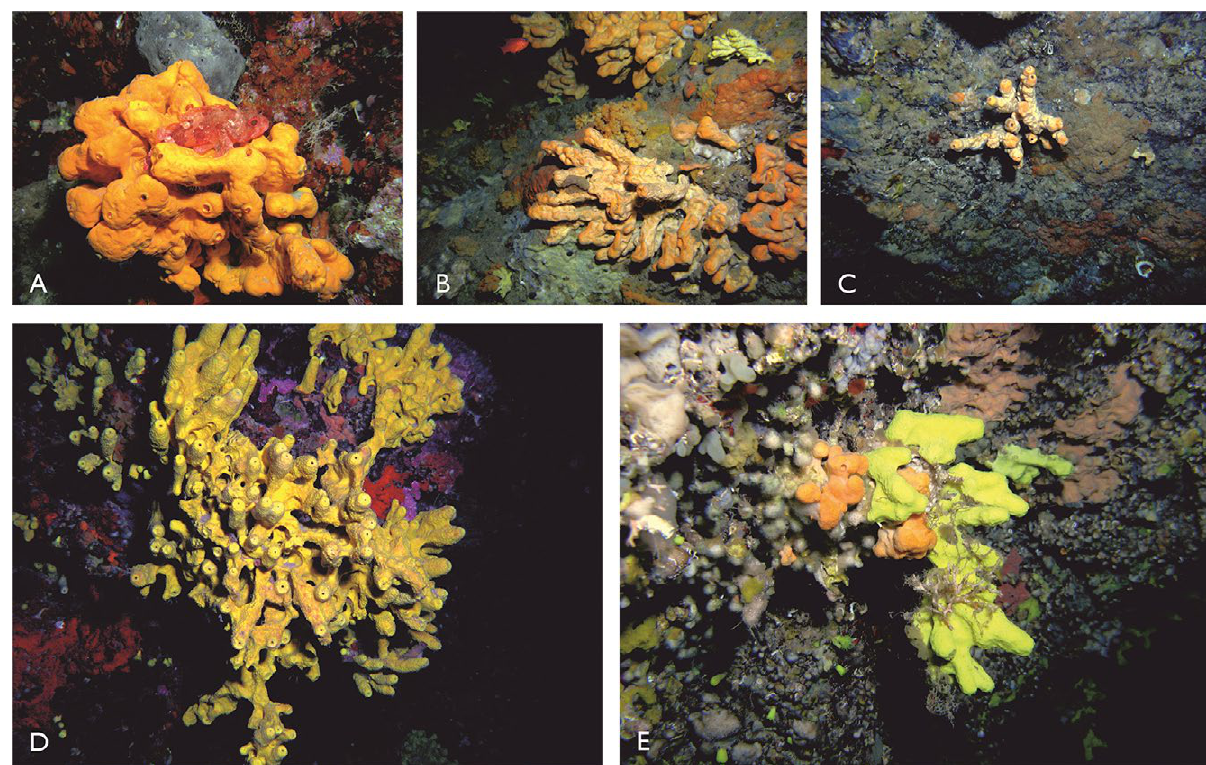
Fig. 1. – The sponge Agelas oroides at the entrance (A), semidark (B) and dark zone (C) of Fara cave and the sponge Aplysina aerophoba at the entrance (D) and semidark zone (E) of Agios Vasilios cave. A small-sized specimen of the sponge Agelas oroides has developed on the basis of the sponge A. aerophoba